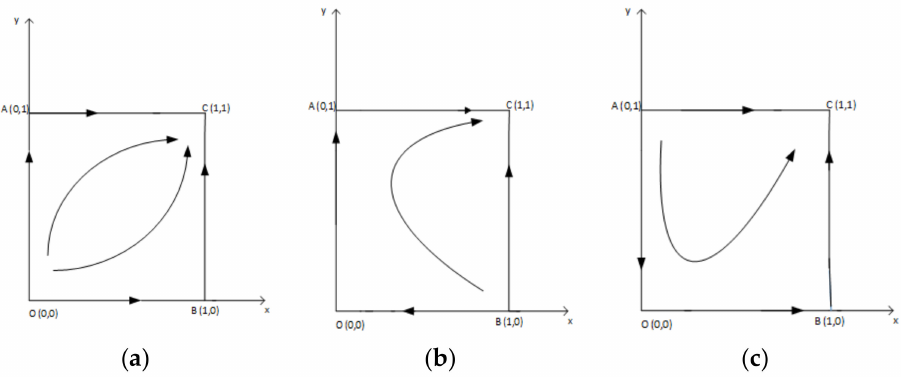
Figure 2. Evolutionary game phase diagrams for active online lending platforms. ( a ) Scenario I; ( b ) Scenario II; ( c ) Scenario